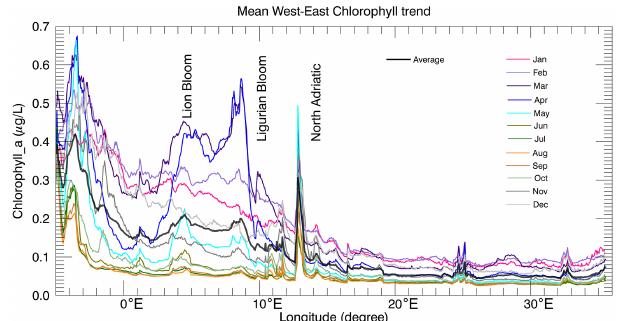
Figure 3. West to east climatological monthly mean chlorophyll a concentration (µgL − 1 ) over the basin for the time series 1998– 2010. The coloured lines are built up averaging all pixels from north to south for each longitude degree of the basin, moving from west to east. The high chlorophyll a values of the Gulf of Lion, Ligurian Sea and North Adriatic Sea are highlighted in the figure (see also the map of the Mediterranean Sea in Fig. 1).